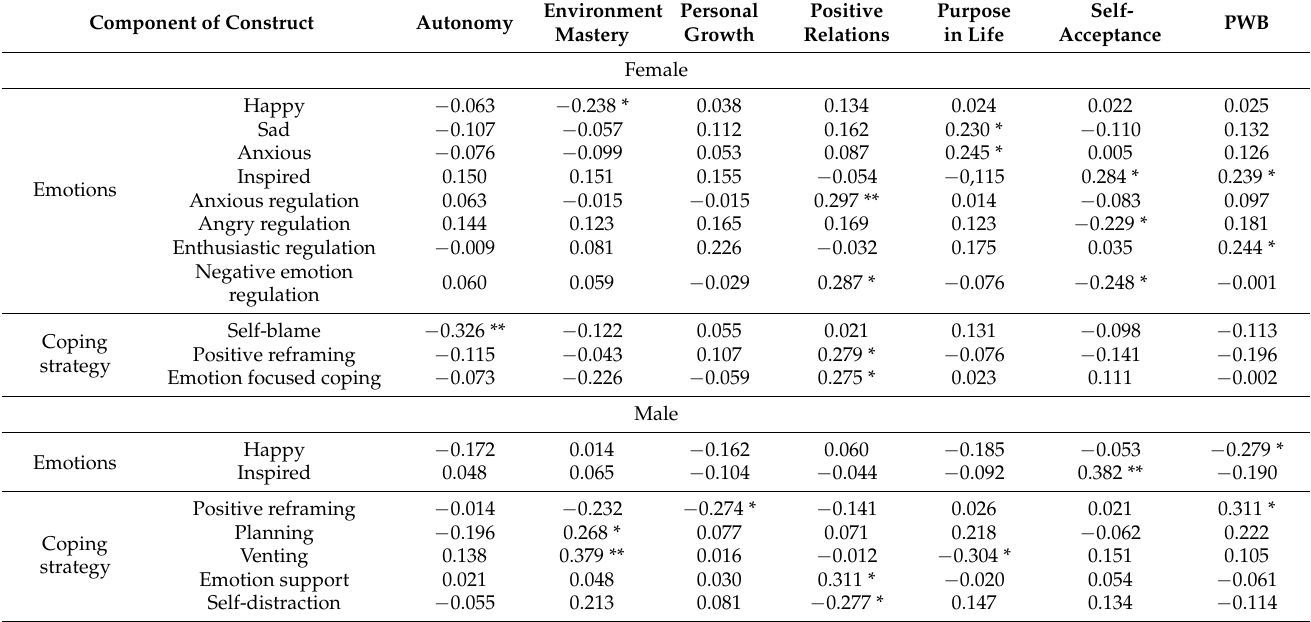
Table 5. The correlation coefficient between psychological well-being and components of emo- tion